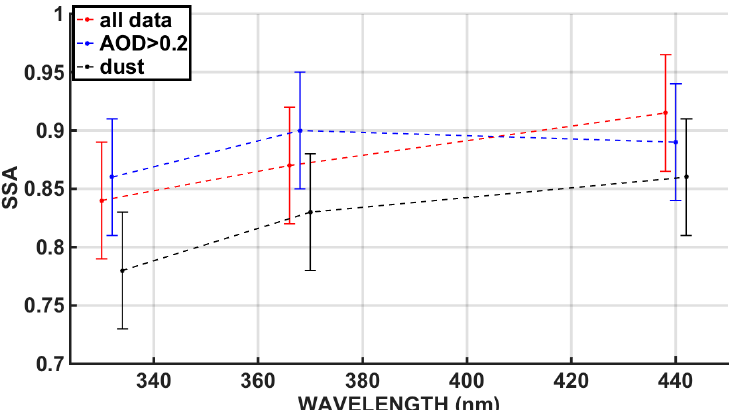
Figure 2. Mean SSA in UV and lower visible wavelengths, as measured in Athens for the period 2009–2014 (332 and 368 nm measured by UVMFR and 440 nm measured by CIMEL). Averages for all data, for AOD > 0.2 and for dust cases (Angström exponent < 0.7), are shown with different colors.